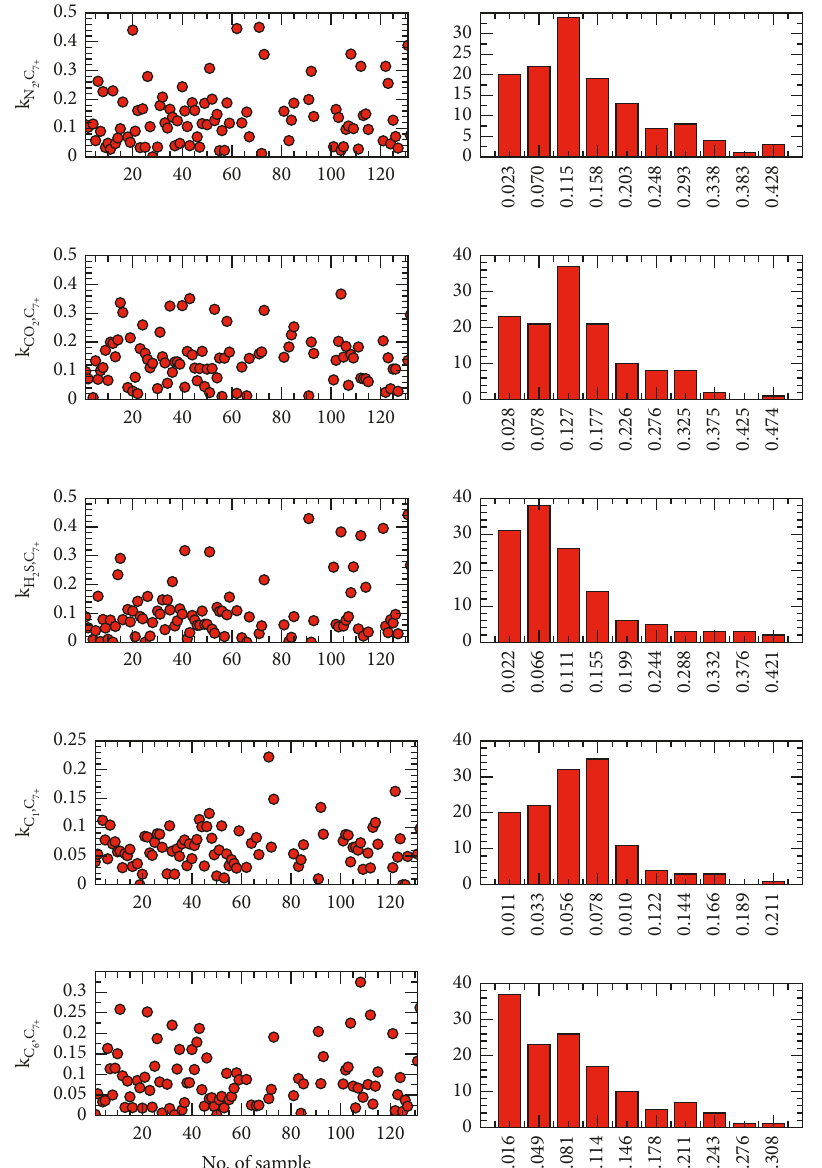
Figure 1: Examples of estimated binary interaction coefficients related to the plus fraction. Graphics in the right column are the cor- responding frequency